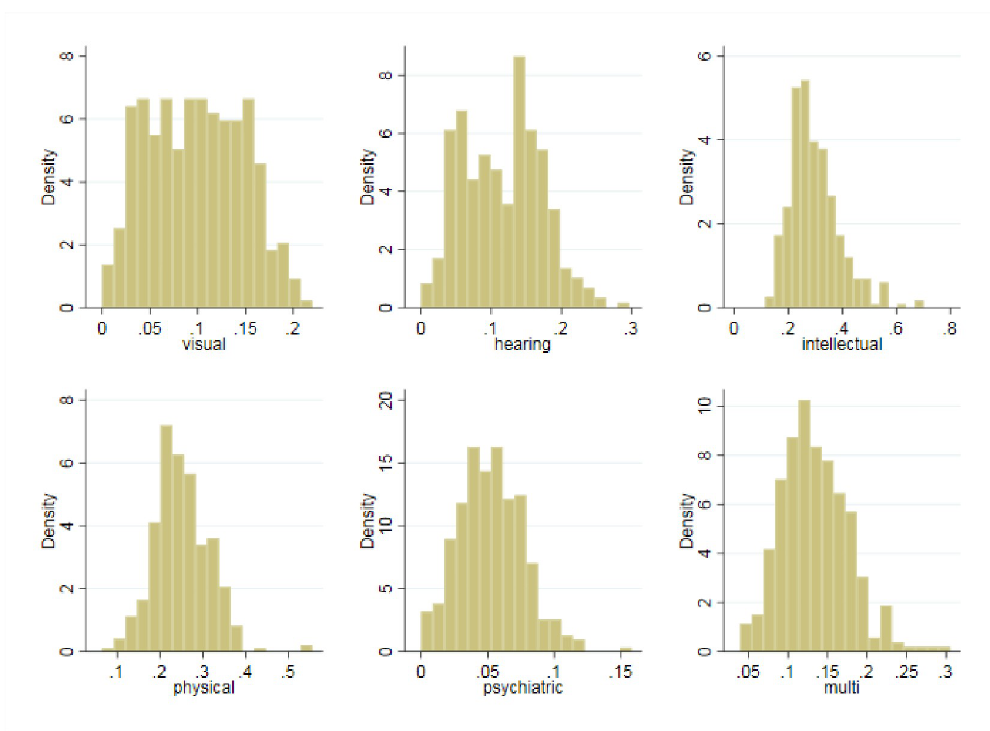
Fig 12. The proportion distribution of different sub-types of RSE. Data source is the official website of China Disabled Persons’ Federation . Drawn by STATA